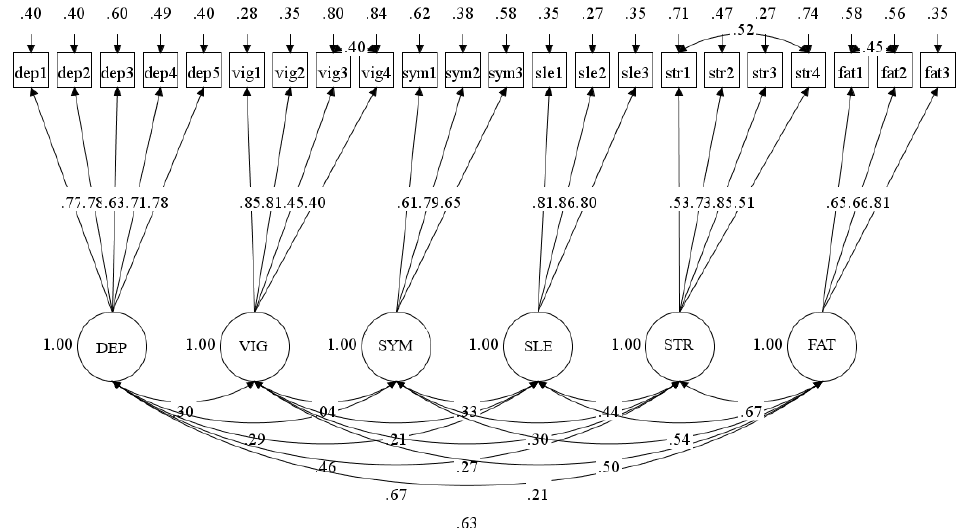
Figure 2. Standardized factor loadings, covariance estimates, and residual variances from the alternative model with three specified error covariances (vig3 with vig4; str1 with str4; fat1 with fat2). Table 8. Calculated McDonald’s ω along with confidence intervals (CIs) to estimate scale reliability. Factor